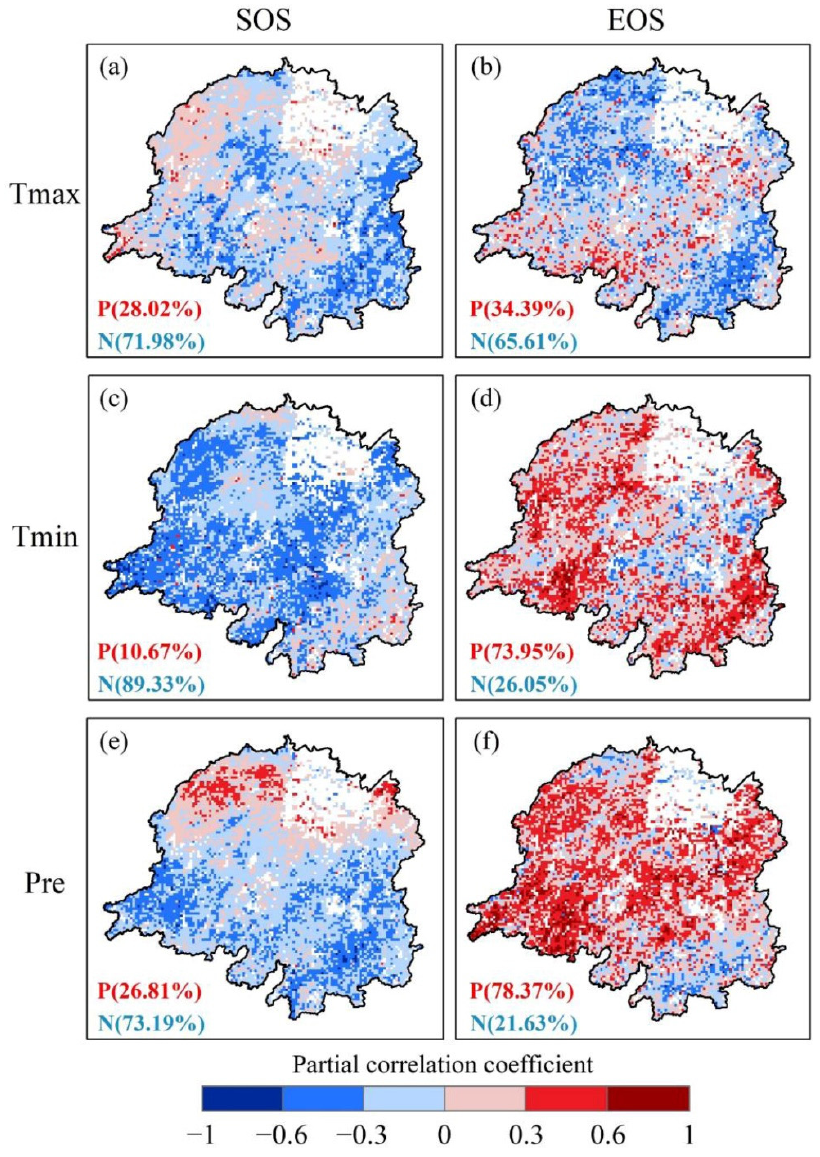
Figure 8. Partial correlation coefficient between phenology indicators and maximum temperature (Tmax), minimum temperature (Tmin) and precipitation (Pre) in the Dongting Lake basin. ( a , c , e ) start of the growing season (SOS) and ( b , d , f ) end of the growing season (EOS). The sensitivity of SOS and EOS to climate factors differed substantially at different urbanization levels. The sensitivity of SOS to the preseason maximum temperature and preseason precipitation decreased and increased, respectively, with an increase in the inten- sity of urbanization, whereas SOS sensitivity to the preseason minimum temperature did not change substantially, showing a trend of first increasing then decreasing (Figure 9). For EOS, sensitivity to the preseason maximum temperature increased substantially from